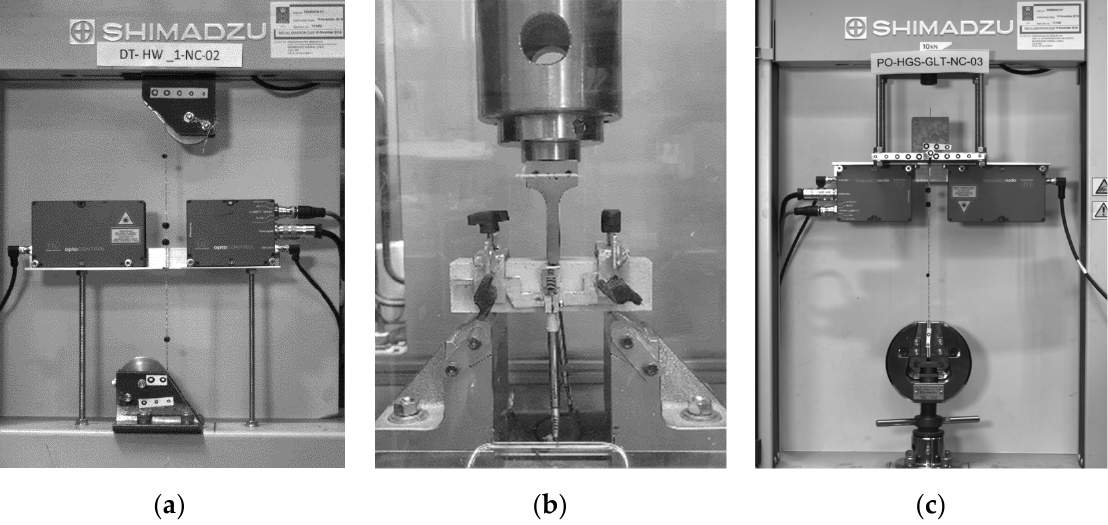
Figure 1. Experimental tests set-ups. ( a ) Direct tensile test on single UHTSS cord; ( b ) Flexural test on mortar prism; ( c ) Pull-out test on UHTSS cord embedded in mortar.